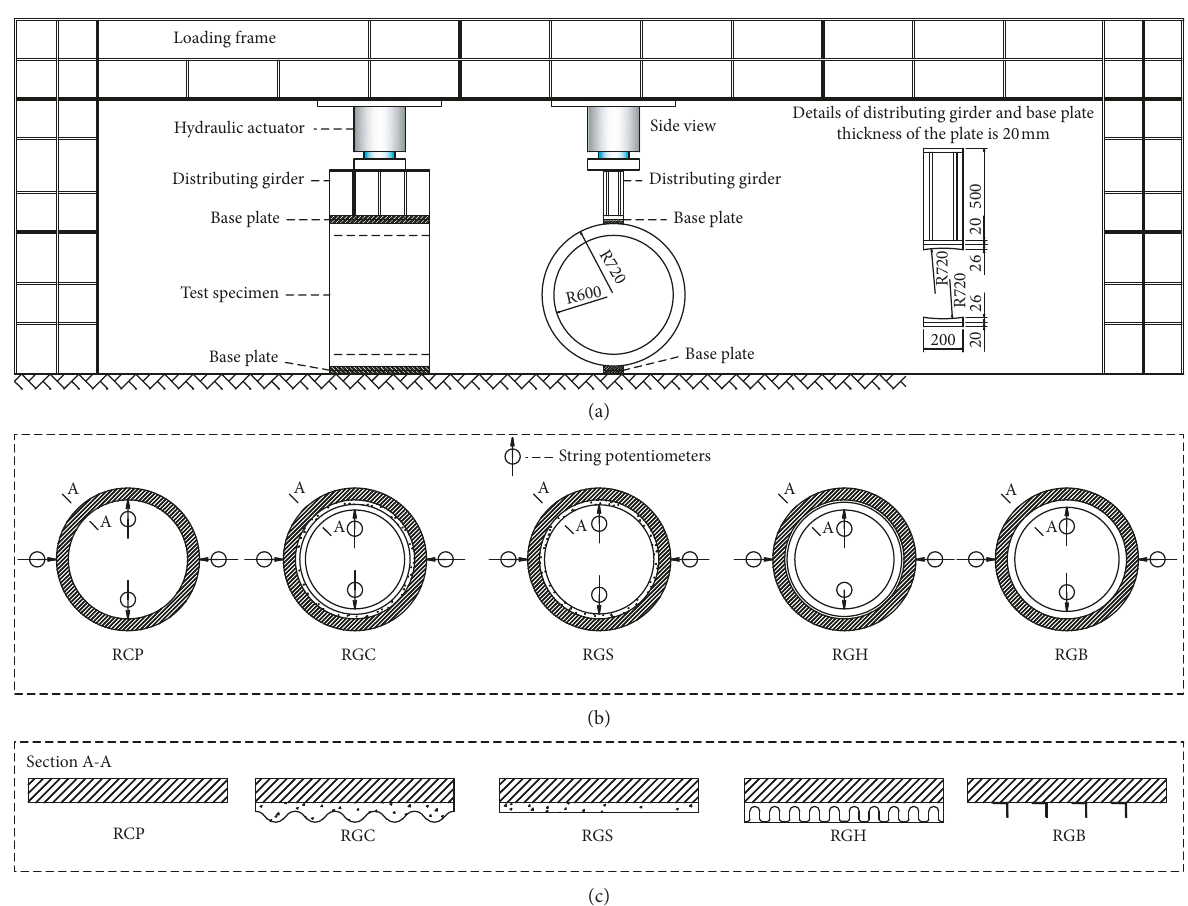
Figure 1: The schematic of loading frame: (a) longitudinal section; (b) cross section; (c) section A-A.